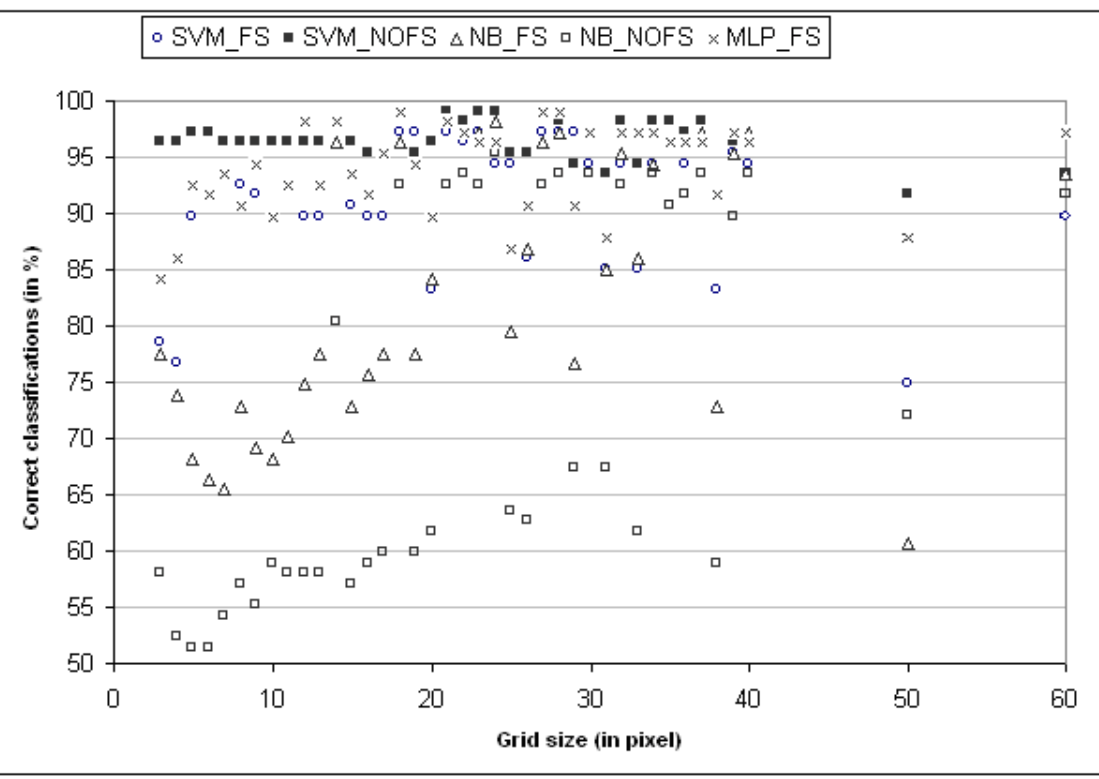
Figure 4: Comparison of classification results for different grid sizes for the following methods: Support Vector Machine (SVM), Naive Bayes Classifier (NB) and Multi Layer Perceptron (MLP). SVM and NB have been evaluated with and without prior feature selection (FS and NOFS respec- tively). For runtime reasons, MLPs without FS have only been tested for grid sizes ≥ 25 px. The picture shows that the classification performance is best on grids sizes between 18 and 28 px using MLPs or